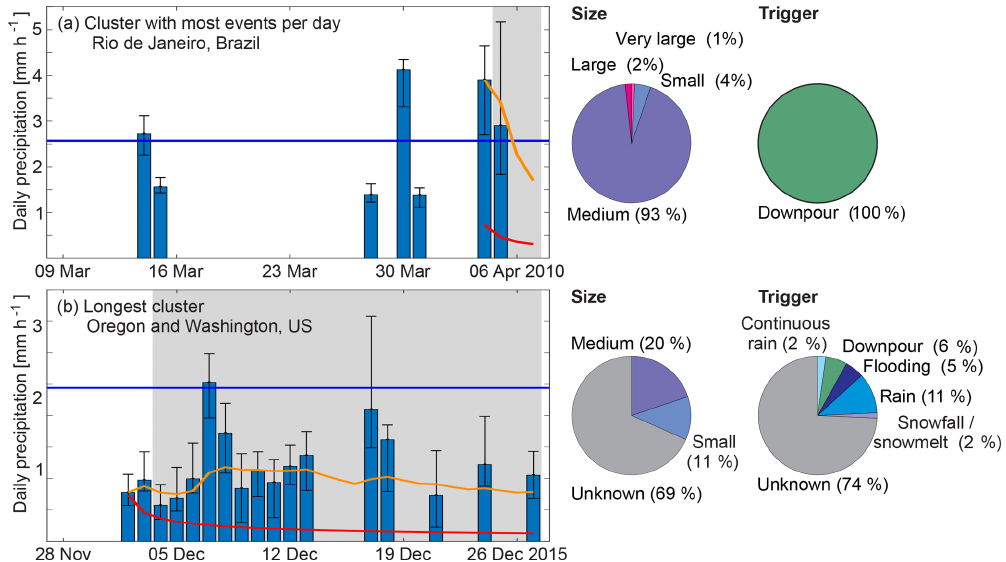
Figure 6. Daily precipitation for 30d preceding the last landslide event of the cluster showing the size of the associated landslide events and their trigger according to the GLC. Shown is the median precipitation for all landslide locations with the inner quartiles as an error bar. The 95th percentile of daily rainfall (rainy days only) in the 10 years preceding the event is given in blue, the global rainfall threshold ID in red (Guzzetti et al., 2008), and the cumulative mean for the rainfall event preceding the cluster in orange. (a) The cluster with the most events per day (ID 43) and (b) the longest-running cluster (ID 22).